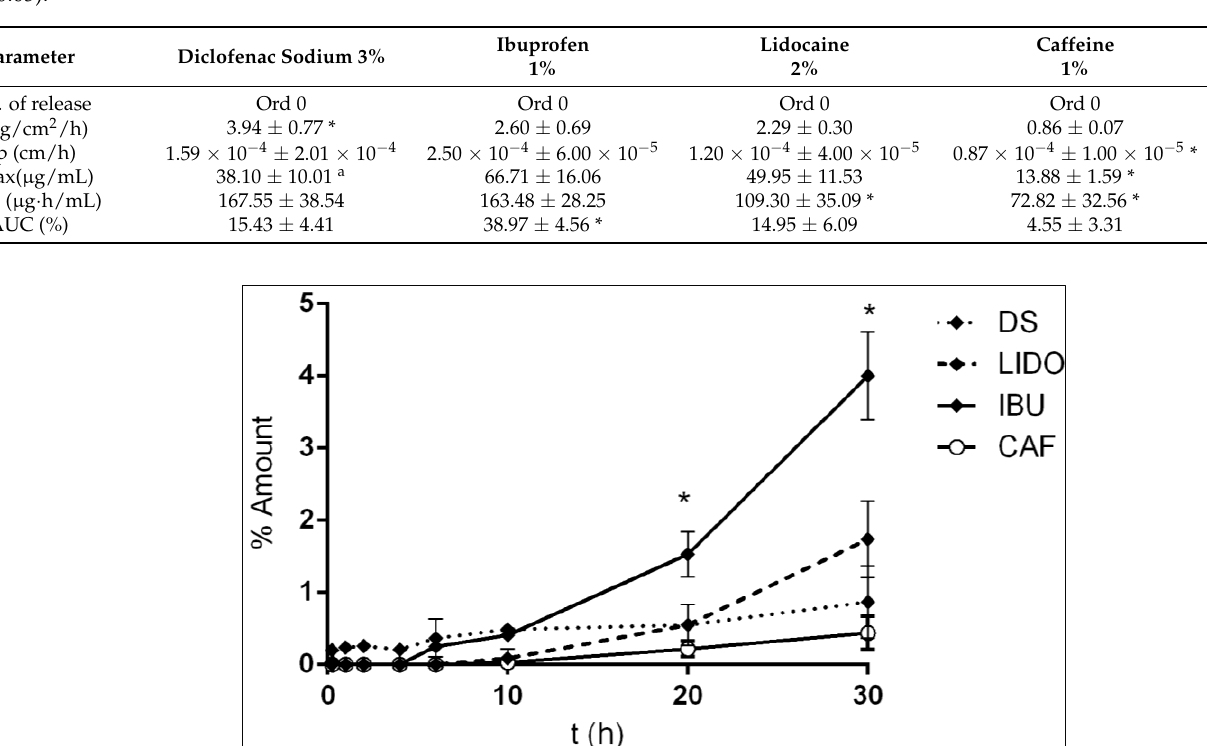
Table 3. Mean values of flux (J), permeability coefficient (Kp), maximum concentration (Cmax), and area under the curve (AUC) for Table 0. (* indicates significantly different, p < 0.05; a indicates significantly different compared to ibuprofen, p < 0.05).